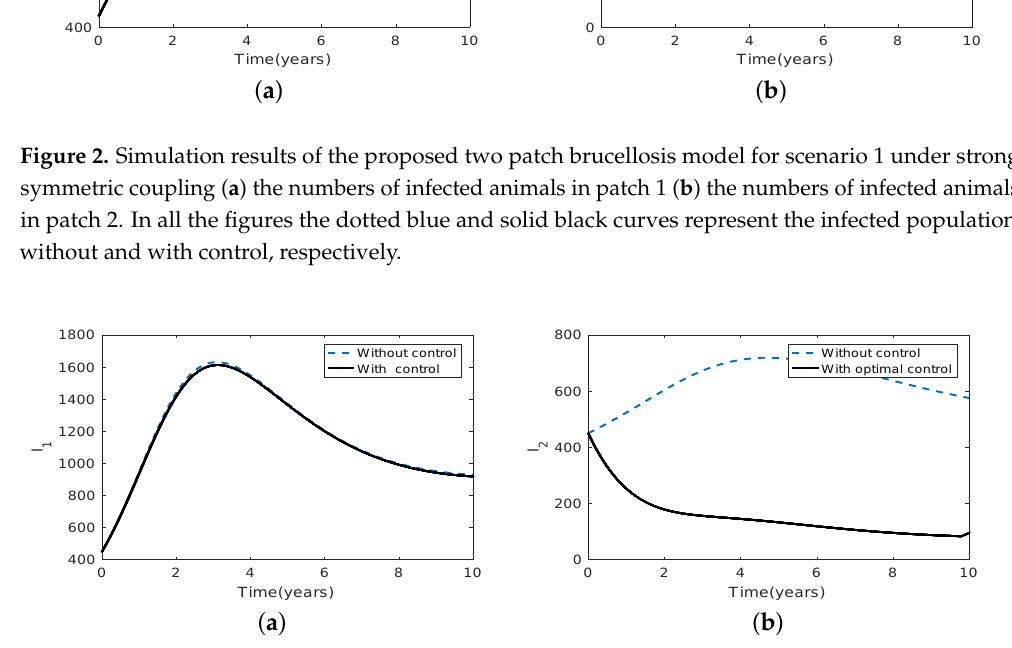
Figure 3. Numerical illustrations demonstrating the effects of optimal intervention strategies on controlling the long-term brucellosis dynamics for scenario 1 under weak asymmetric coupling ( a ) the numbers of infected animals in patch 1 ( b ) the numbers of infected animals in patch 2. In all the figures the dotted blue and solid black curves represent the infected population, without and with control, respectively.